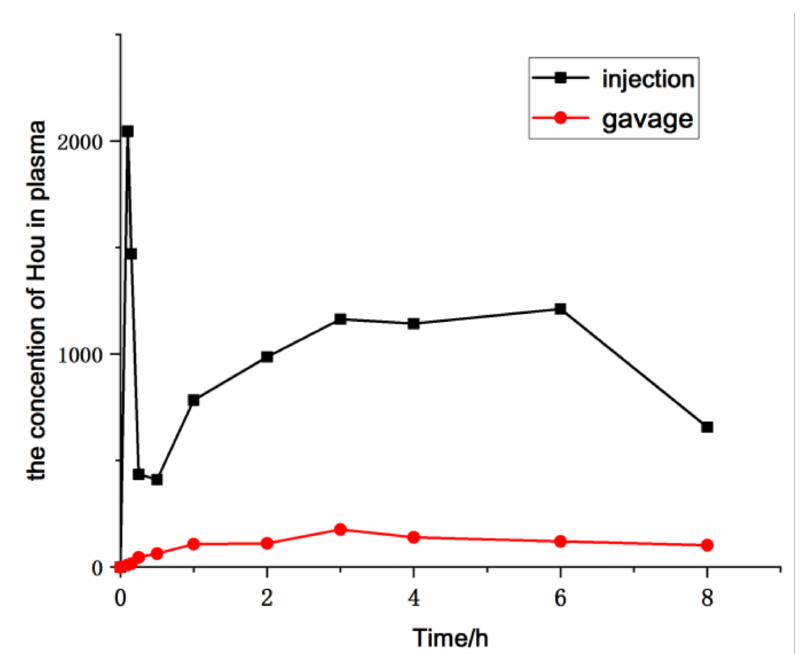
Figure 7. Mean plasma concentration–time profile of Hou in rats after a single administration of HEO by different administration forms ( n =